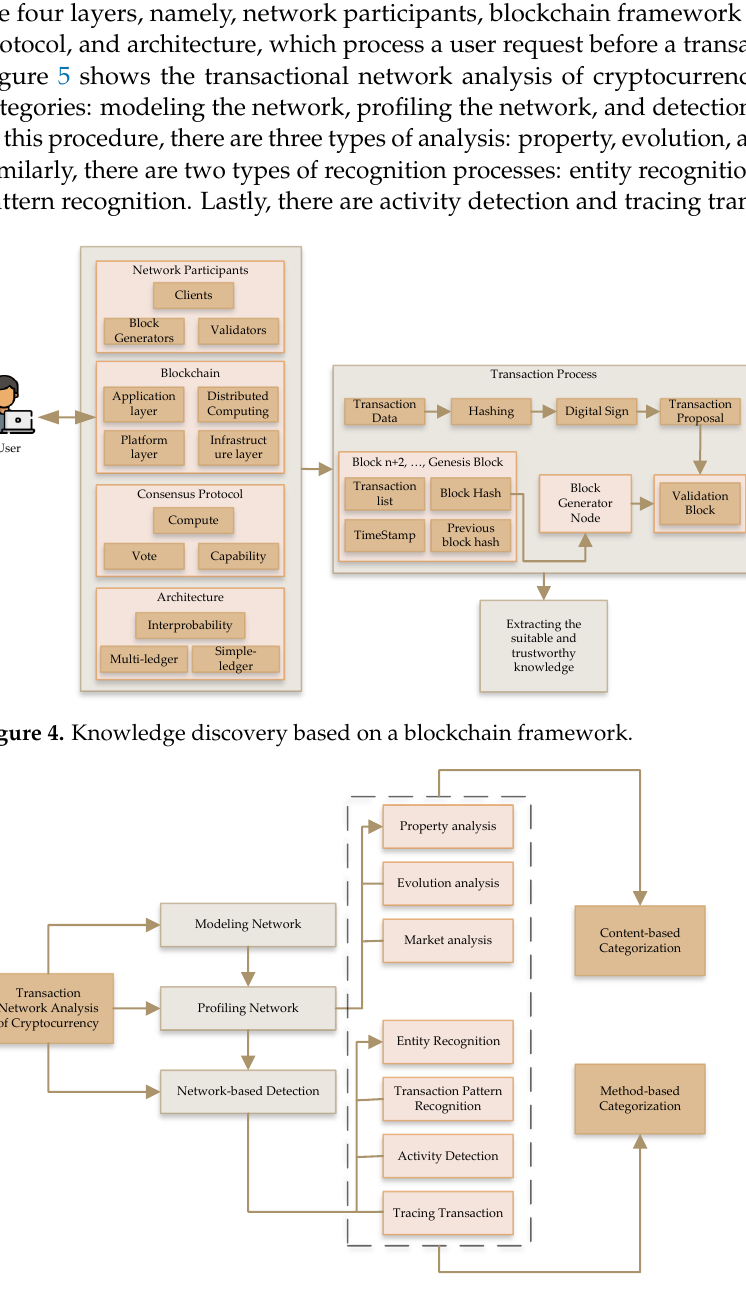
Figure 5. Network analysis of cryptocurrency